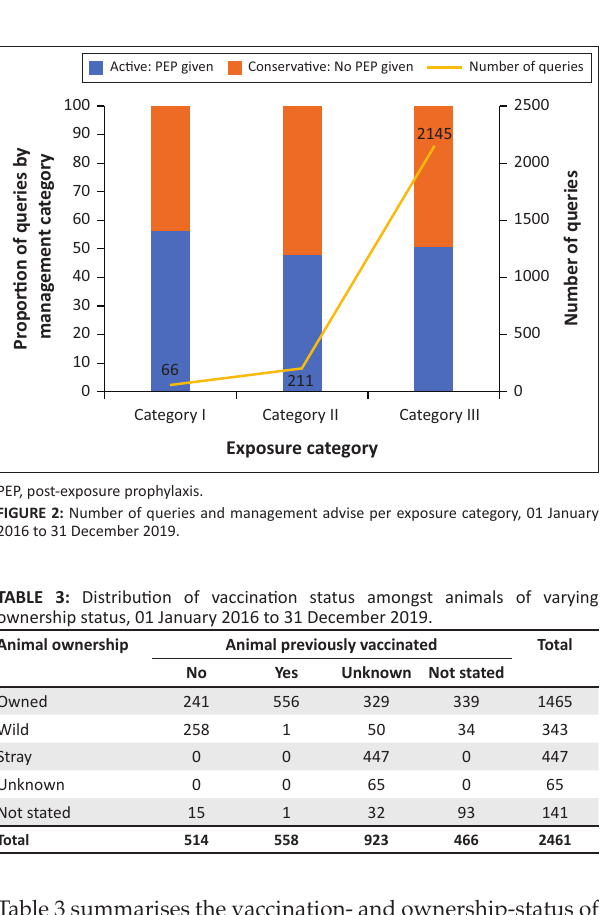
FIGURE 1: Proportion of queries per animal exposure.